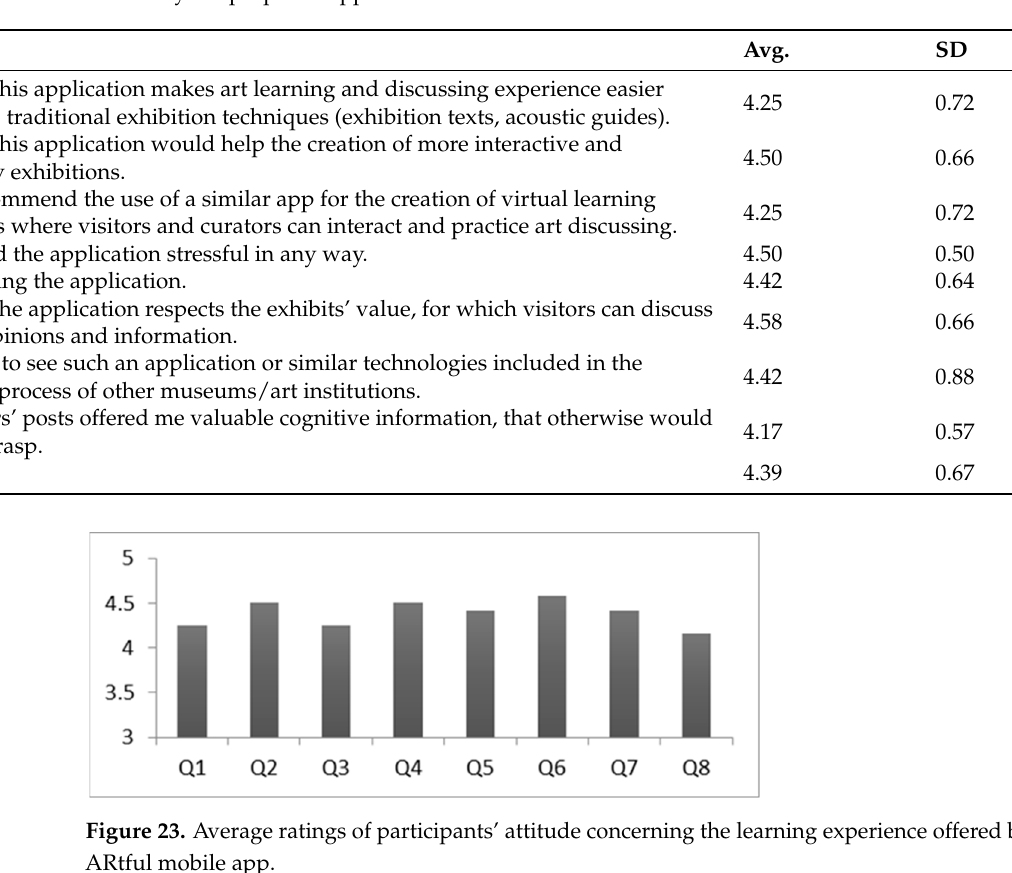
Table 7. Questions and average ratings of participants’ attitude concerning the learning experience offered by the proposed app.